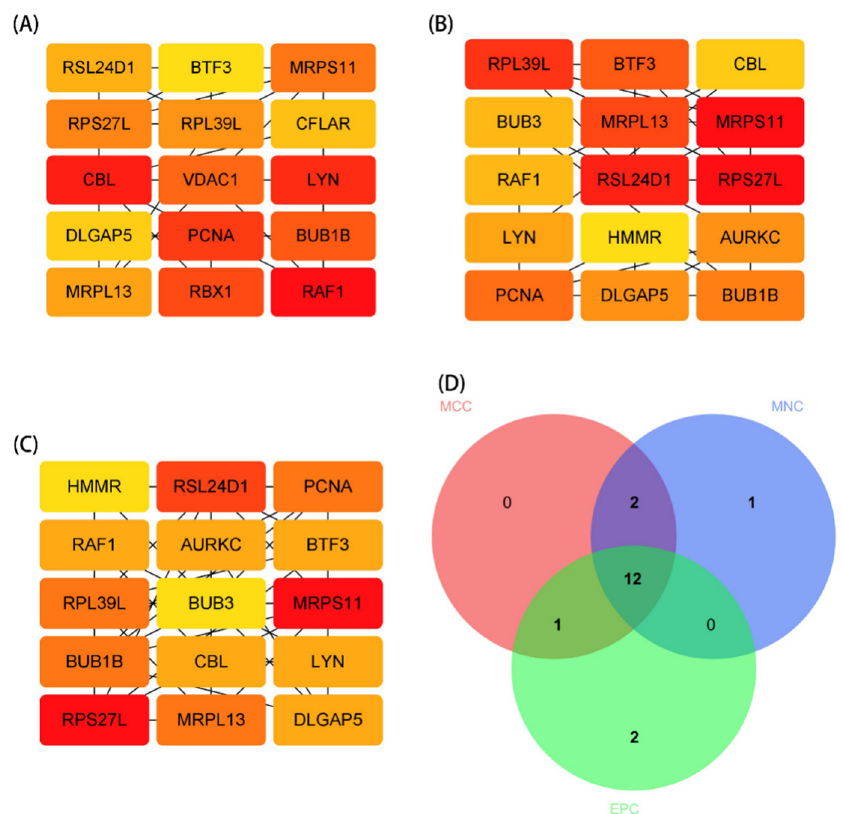
Figure 5. Screening of hub differentially expressed genes (DEGs). ( A – C ) Hub DEGs screened by the MCC, EPC, and MNC algorithms. ( D ) The Venn diagram showed the common hub DEGs between MCC, EPC, and MNC algorithms.